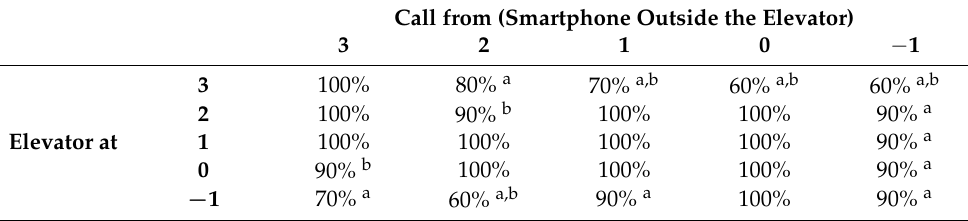
Table 2. Success rate when accessing to the IoT device controlling the elevator with a smartphone from outside of the car.